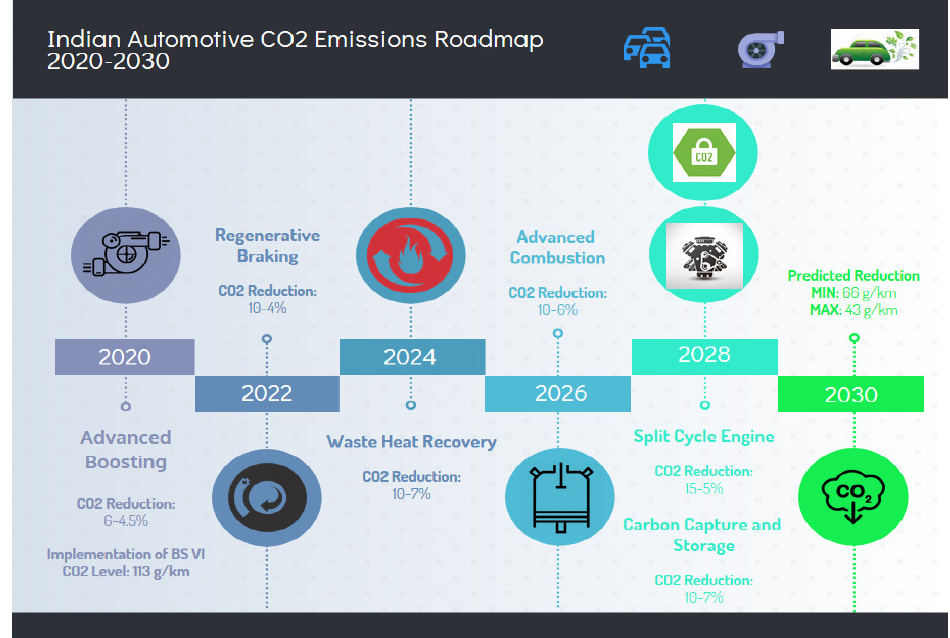
Figure 8. Indian Automotive CO 2 Emissions Roadmap for 2020-2030.